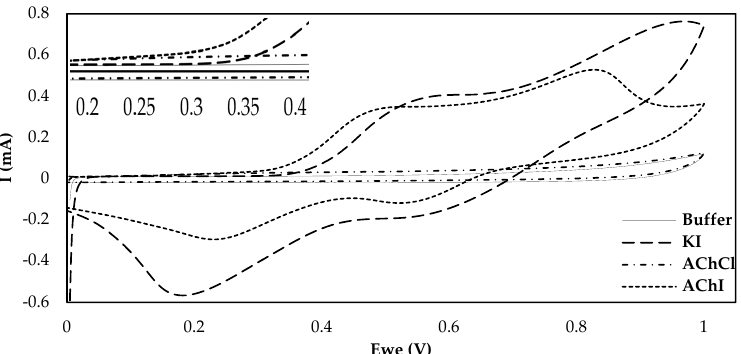
Figure 1. Cyclic voltammograms on CB / CS-modified carbon screen-printed carbon electrodes (SPEs) of phosphate bu ff er, 10 mM AChCl, 10 mM AChI and 10 mM KI at a scan rate of 50 mV / s. An enlarged image of the CVs at potentials between 200 and 400 mV is provided in the inset.